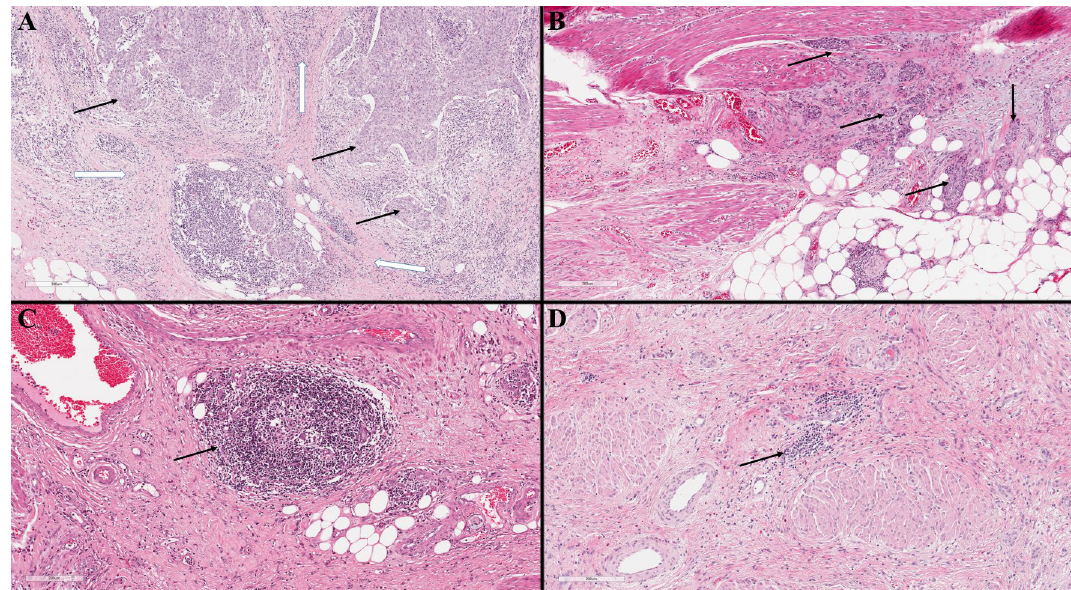
inflammation (black arrows indicate invading carcinoma, white arrows the stroma), ( B ) low power image with minimal invasive front inflammation (black arrows highlight areas of carcinoma), ( C ) well defined lymphoid structure with germinal centre in keeping with a tertiary lymphoid structure (indicated by black arrow), ( D ) loose collection of lymphocytes comprising a lymphoid aggregate (indicated by black